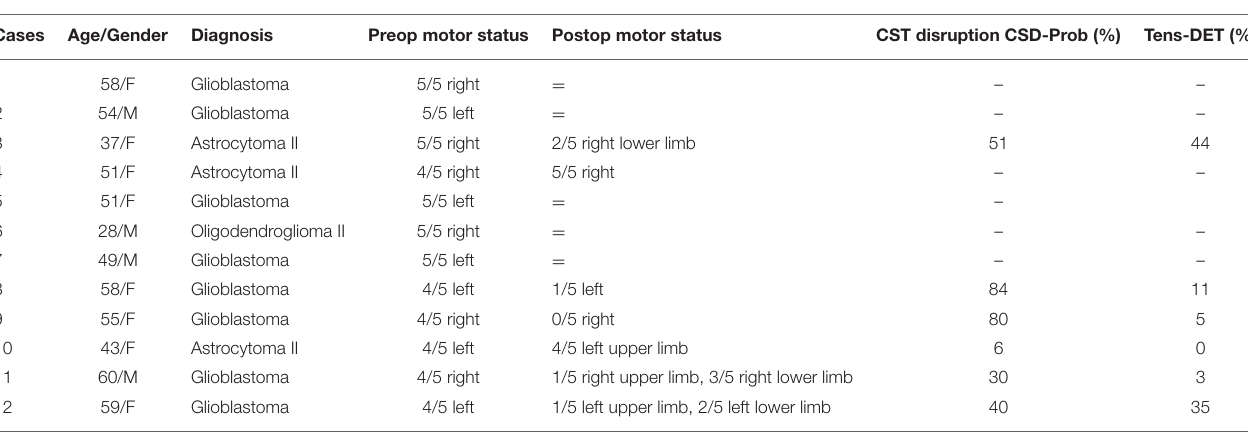
TABLE 1 | Clinical and demographics data of the